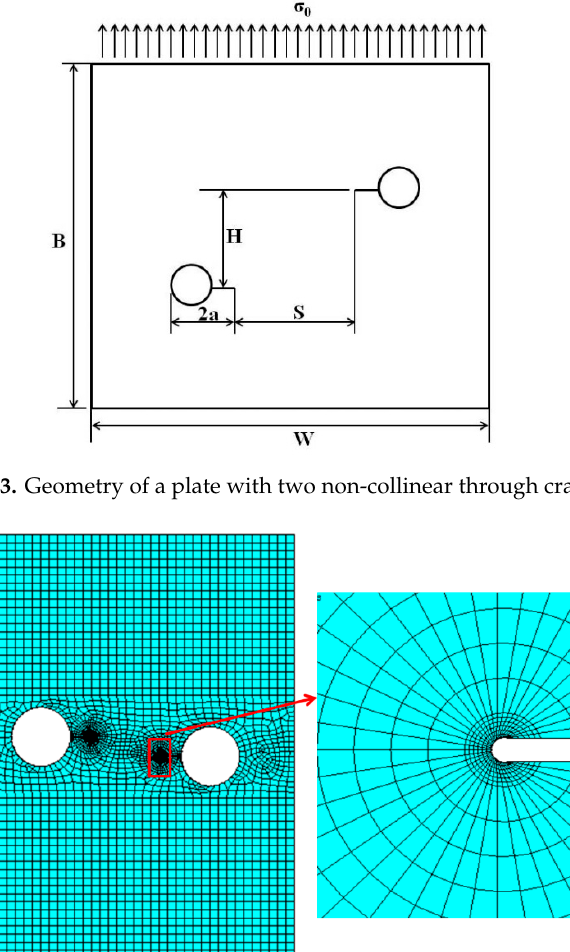
Figure 4. An example finite element mesh.